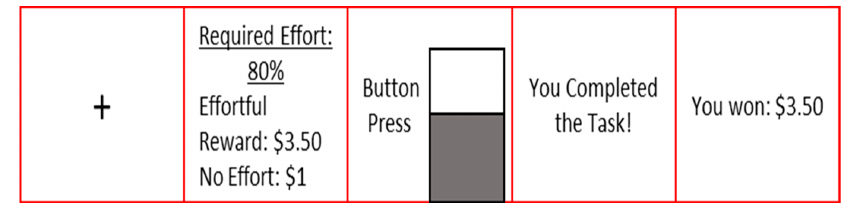
Figure 2. E ff ort-based decision-making task procedure. This is an example of an 80% e ff ort trial with a reward of USD 3.50. Each trial began with the presentation of a fixation cross (Box 1). Participants then saw a Decision Prompt that prompted them to make a choice between the E ff ort Option presented (USD 3.50; Block 2) and the No E ff ort Option that always paid USD 1.00. They were required to make their selection within 3 seconds. They then used the keyboard to complete the task (Box 3). They were then told whether they completed the task (Box 4) and the reward amount won (Box